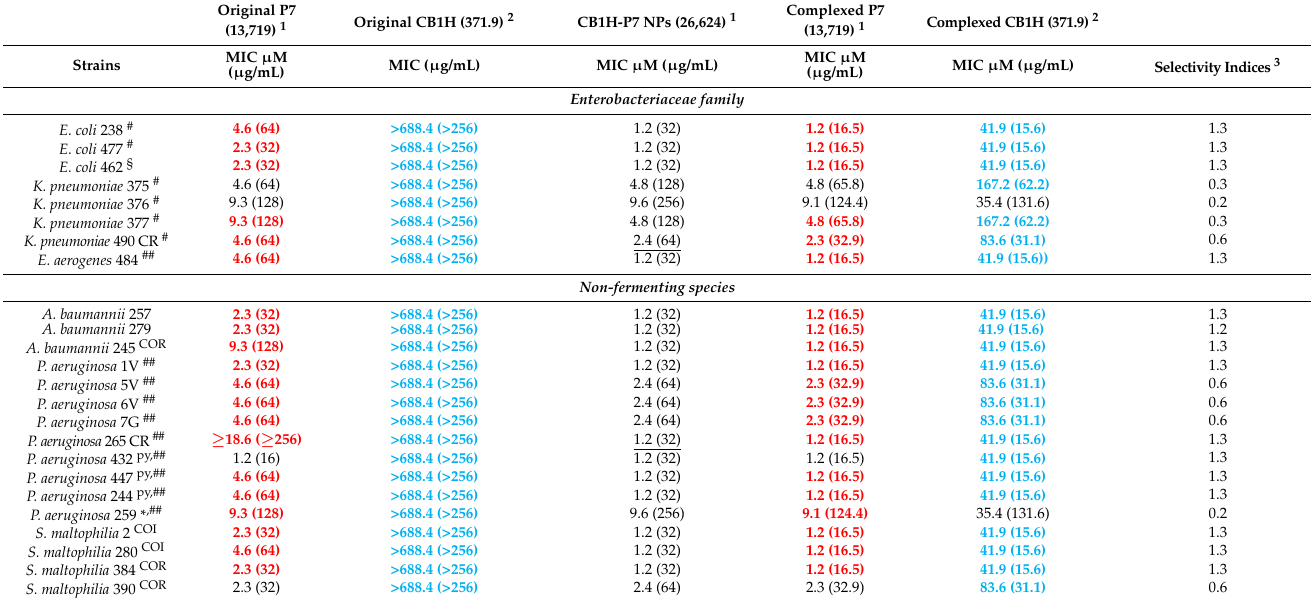
1 average molecular mass (Mn); 2 MW; 3 refers to CB1H-P7 NPs; * denotes vancomycin resistant (VRE), * ,# VRE resistant also to teicoplanin; ** denotes methicillin resistance; *** denotes resistance toward methicillin and linezolid; red bold data evidence the MICs of original P7 and complexed P7, according to which the latter was 2-fold more potent than the first; light blue bold data evidence the MICs of pristine CB1H and complexed CB1H, according to which the latter was 2- to 16.4-fold more potent than the not complexed one; black bold data in column seven evidence the highest SIs. Table 4. MIC values of P7 and CB1H when administered alone, MIC values of CB1H-P7 NPs, and those of P7 and CB1H in the complex according to the DL% of CB1H-P7 NPs [23], against bacteria of Gram-negative species, obtained from experiments carried out at least in triplicate, expressed as µ M and µ